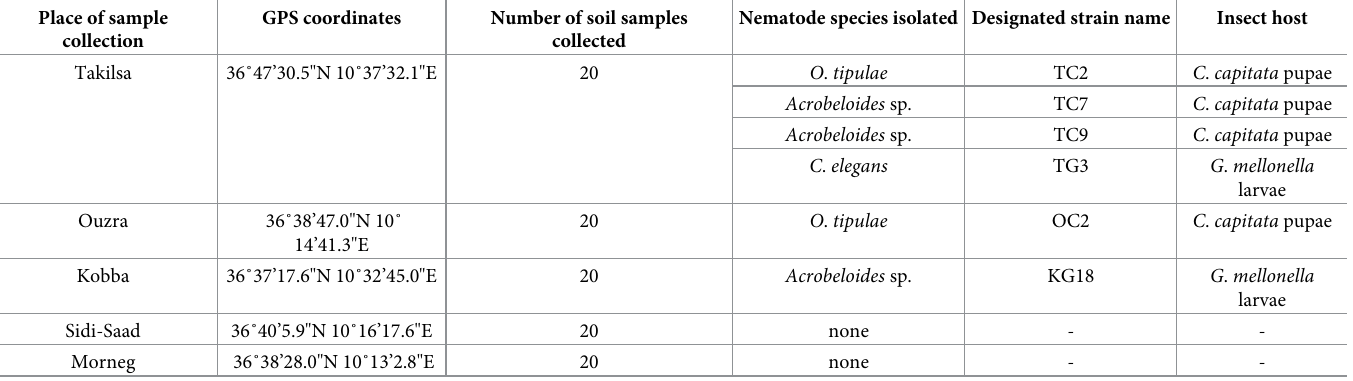
Table 1. Geographical location of nematode sampling sites. Soil samples were collected at five different locations in Tunisia: Takilsa, Ouzra, Kobba, Sidi-Saad, and Mor- neg. Place of sample collection, GPS coordinates, number of samples collected, nematode species isolated, strain name designation and insect host of the different nema- tode strains